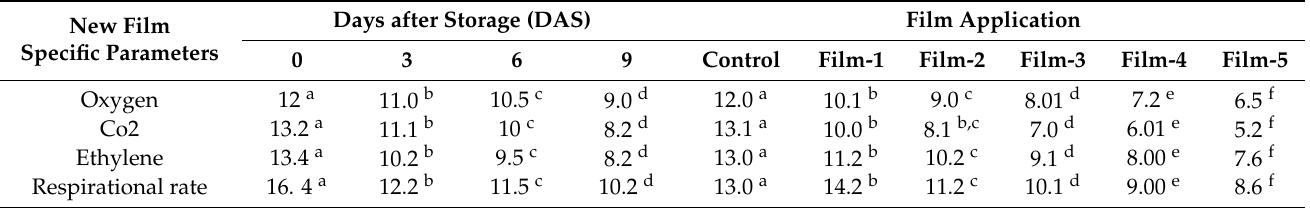
Figure 5. Structural formula of two essential compounds for preparation of films and its develop- mental process. Respirational changes in apples during storage periods under a coating of new films The comparison of storage period and application of new films on respiration changes of apple fruits were measured and shown in Table 4. The higher oxygen, CO 2 , ethylene, and respirational rates were (12, 13, 13.4, and 16.4) were noticed at 0 days, whereas at the others’ storage, like 3, 6, and 9 days showed lower rates shown in Figure 6. Generally, the films’ application on apple reduced the respirational rates as noticed for Film-5. Higher rates of oxygen, CO 2 , ethylene, and respiration were noted, in the untreated fruits. Table 4. Comparisons (DAS and new films) on respirational changes in apple fruits.